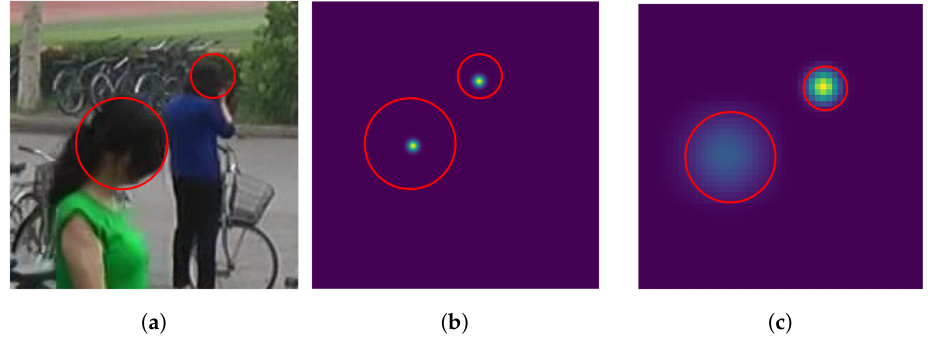
Figure 6. Ground-truth density maps for an image, with and without adaptive-sized kernels. The adaptive kernels capture various head sizes better. ( a ) Image. ( b ) Density map (baseline). ( c ) Density map (adaptive